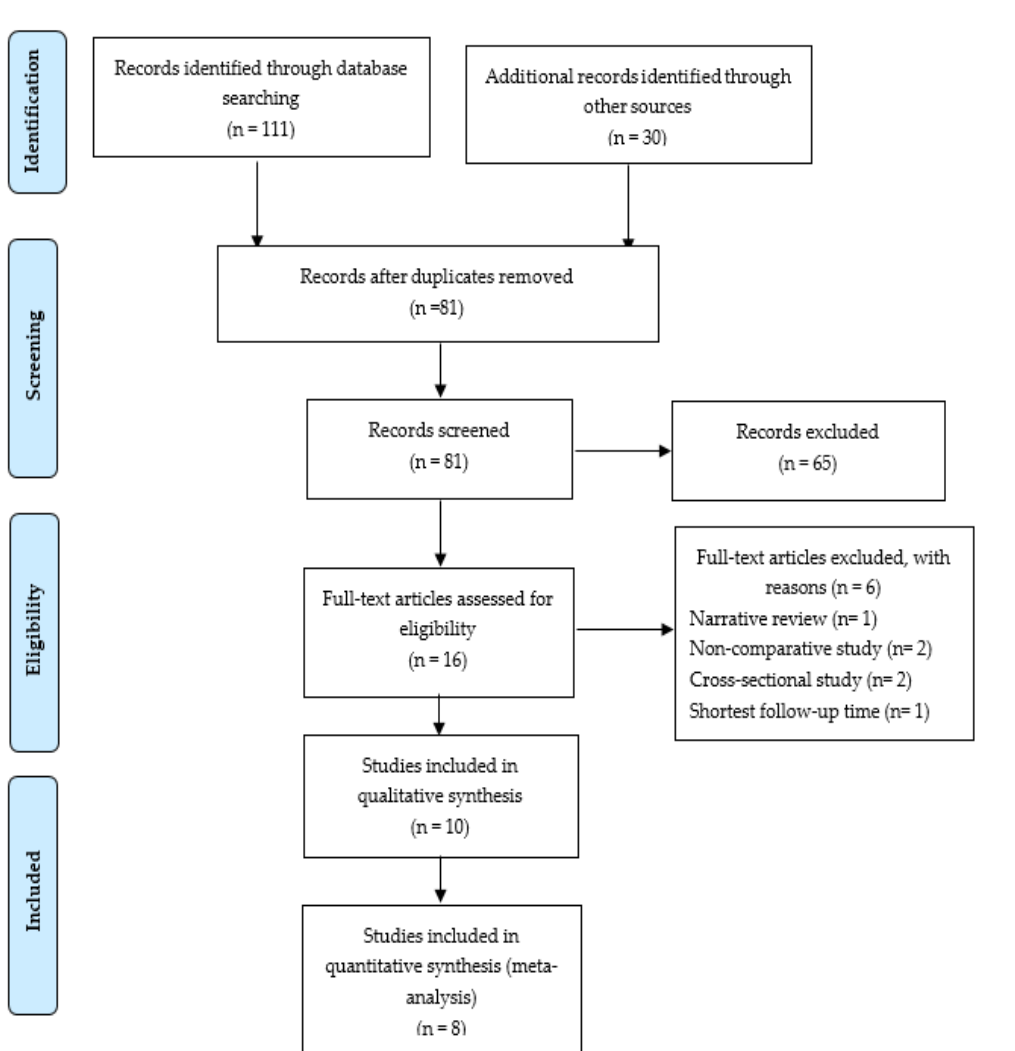
Figure 1. Preferred reporting items for systematic reviews and meta-analyses (PRISMA) flow diagram for article screening and selection process. Table 1. Characteristics of the included studies (n = 10).